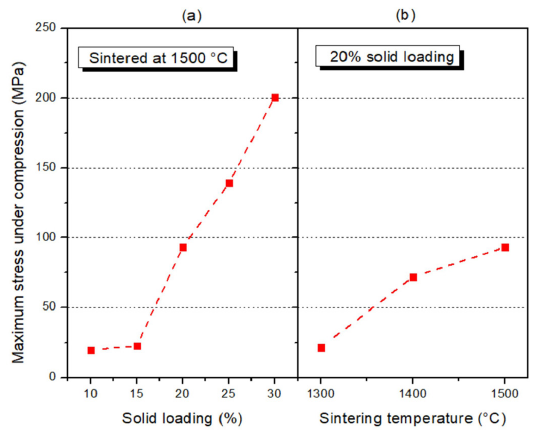
Figure 8. Maximum compressive stresses predicted by the honeycomb model in the X direction that the tubular substrates can withstand 1 before fracture: (a) substrates sintered at 1500 °C, and (b) substrates produced with 20% solid loading.